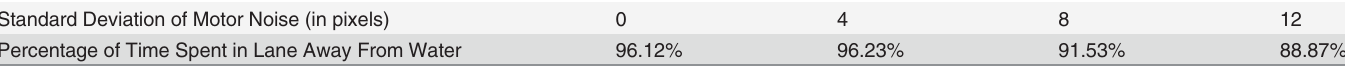
Table 1. Percentage of time spent in the lane farthest from water in the asymmetric cost environment. Standard Deviation of Motor Noise (in pixels)